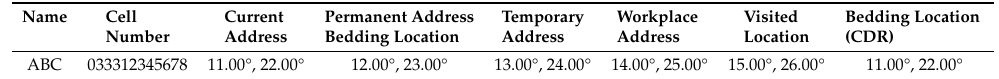
Table 3. Proposed performa to be filled by dengue patient.